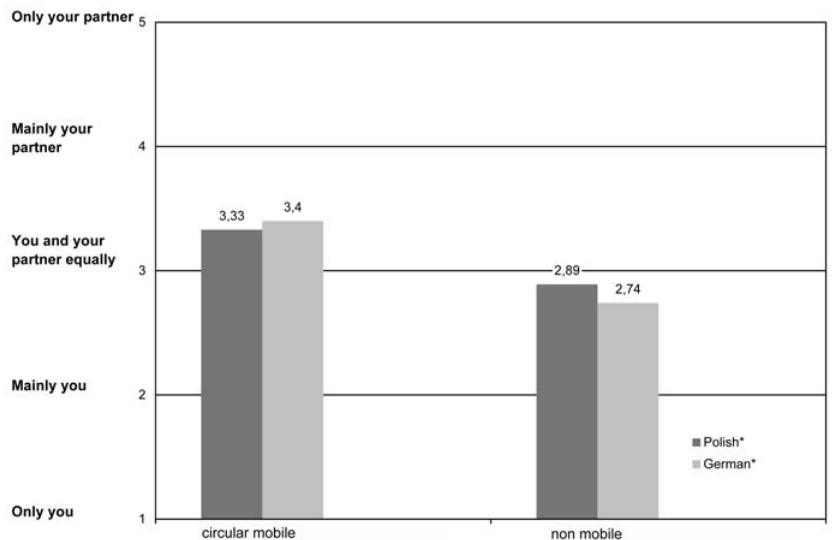
Data: Job Mobility and Family Lives Survey 2007, employed men and women living in partnerships. Unweighted number of cases: Germany n=255, Poland n=199 (weighted data used in